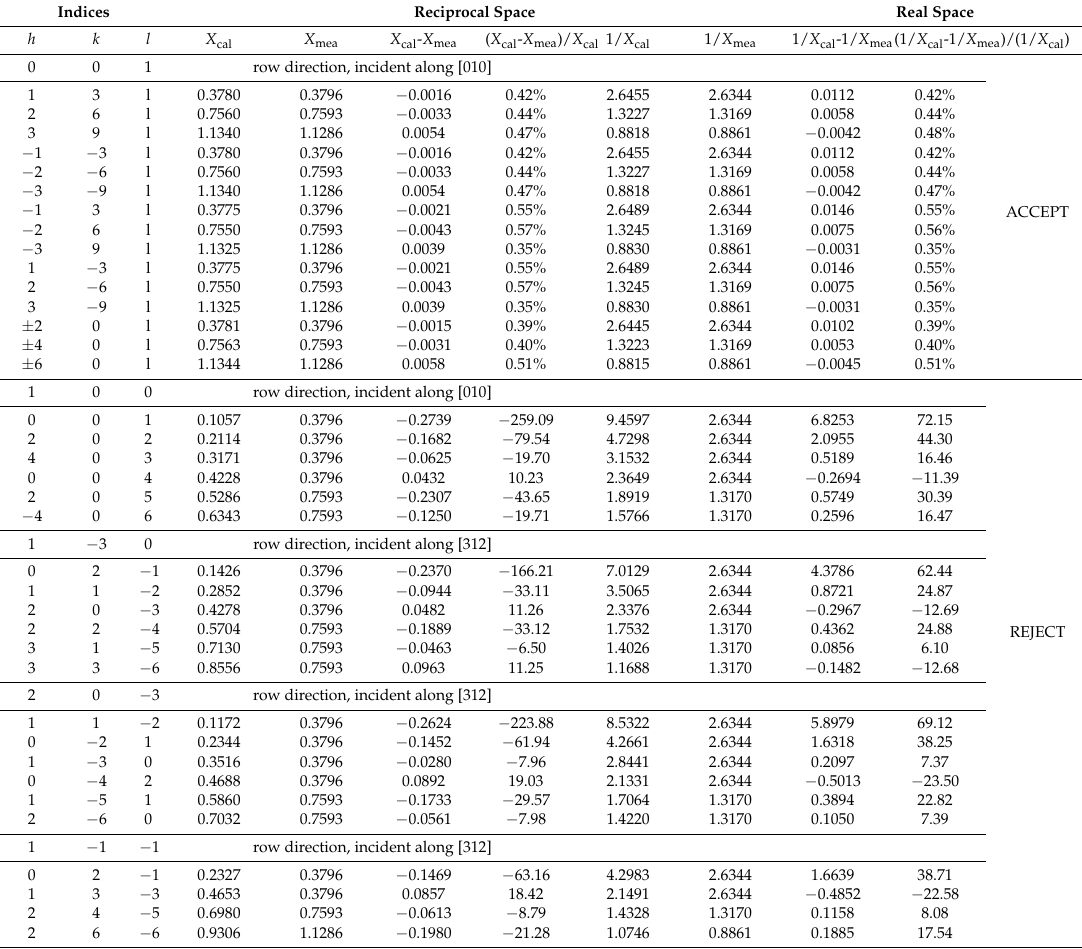
Note: subscripts mea and cal stand for the measured and the calculated respectively and the unit of 1/ X mea and 1/ X cal is Å. *: reject (err >3%), **: reject (spot not on row).